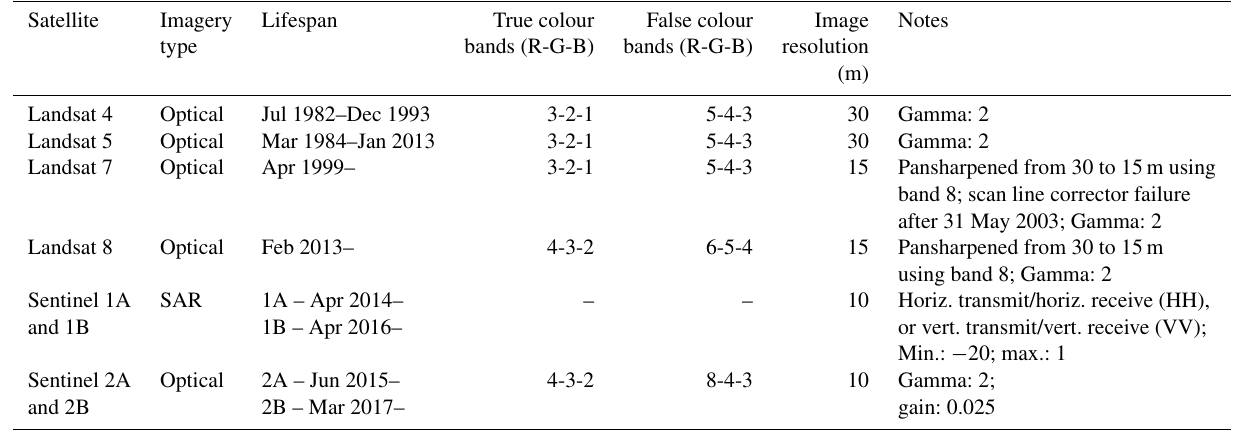
Table 1. Description of satellites and optional band combinations that are built into GEEDiT. Note that certain user-defined custom band combinations may have lower